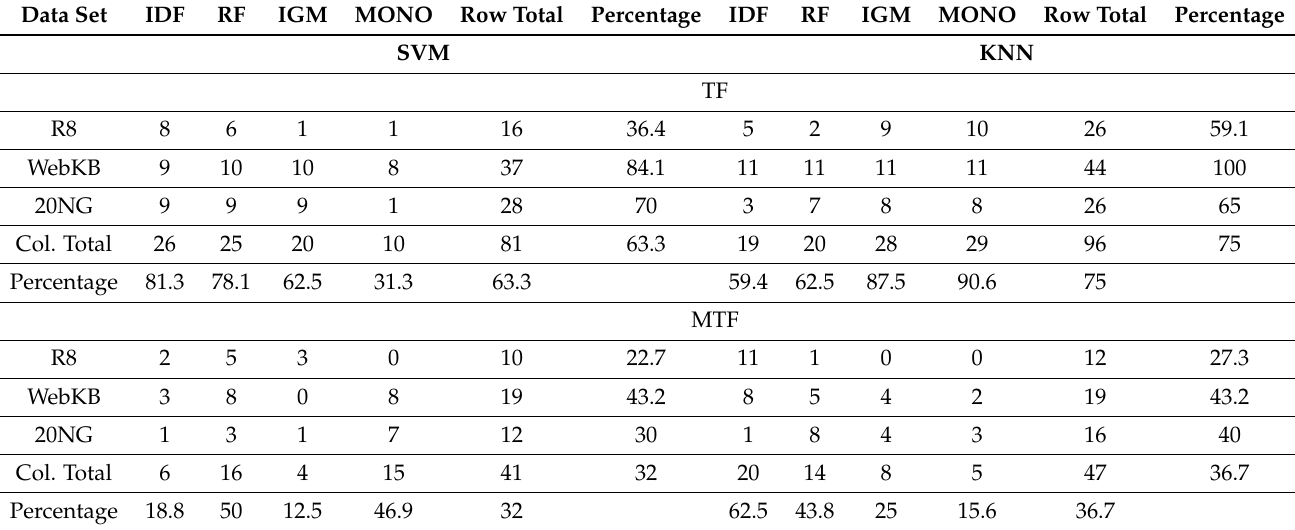
Table 10. Summary: Percentage Wins of BTC against TF and